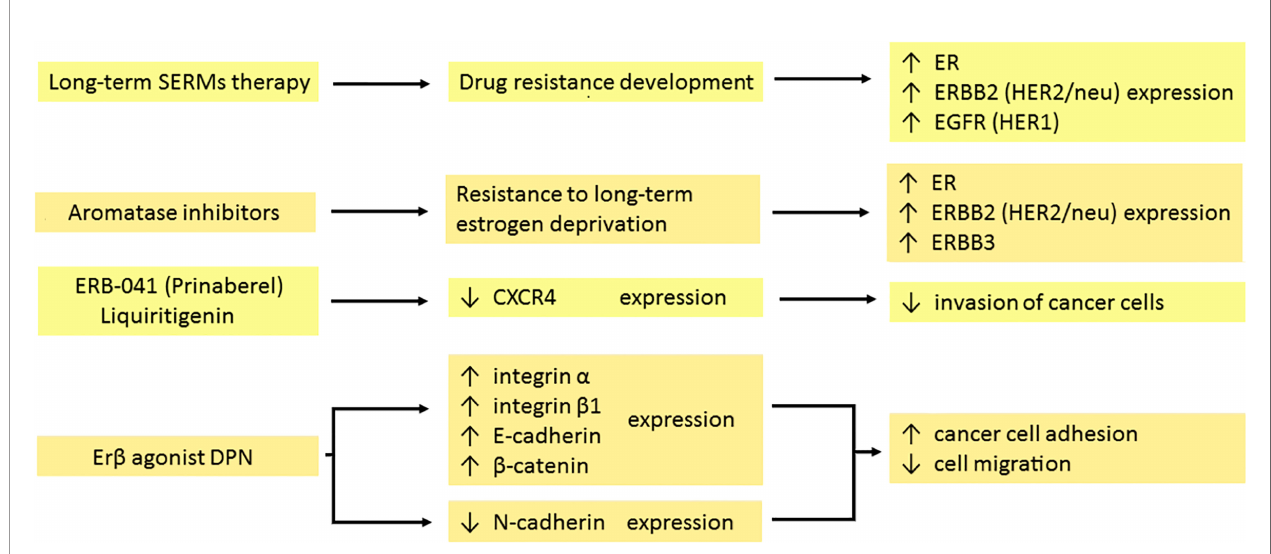
FIGURE 1 | Effects of hormonal therapy of the tumour on the expression of membrane antigens. Long-term therapy with both selective estrogen receptor modulators (SERMs) and aromatase inhibitors (AI) leads to the development of drug resistance. In response, cancer cells increase the expression of several receptors: ER, ERBB2 (HER2/neu), ERBB3 and EGFR (HER1). Prinaberel and liquiritigenin downregulate CXCR4 expression, reducing tumour growth, cell proliferation and invasion. DPN as a selective agonist of the b subunit of the estrogen receptor enhances integrin a and b 1, E-cadherin and b -catenin expression, while suppressing the expression of N-cadherin. It leads to intensi fi ed adhesion and impaired migration of cancer cells. ER, estrogen receptor; ERBB2, erb-b2 receptor tyrosine kinase 2; ERBB3, erb-b3 receptor tyrosine kinase 3; EGFR, epidermal growth factor receptor; CXCR4, CXC motif chemokine receptor 4; DPN,